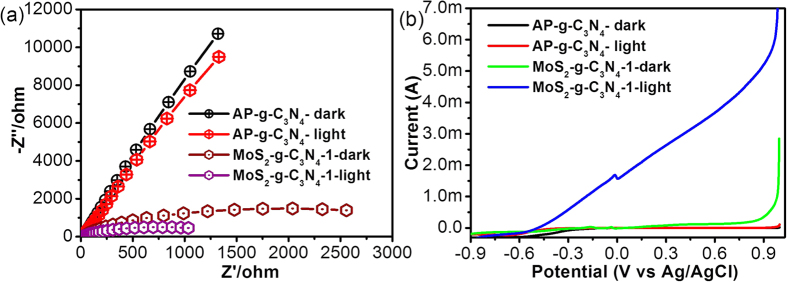
(a) Nyquist plot and (b) Qualitative LSV voltammogram of AP-g-C3N4, and MoS2-g-C3N4-1 heterostructure.